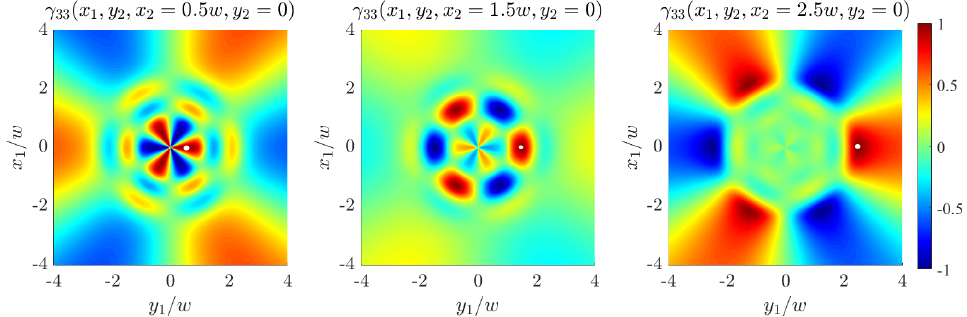
Figure 9. Degree of coherence for a source described by Equations (44) and (45), N = 3, m = 3, relative to three different points indicated by white dots and in the